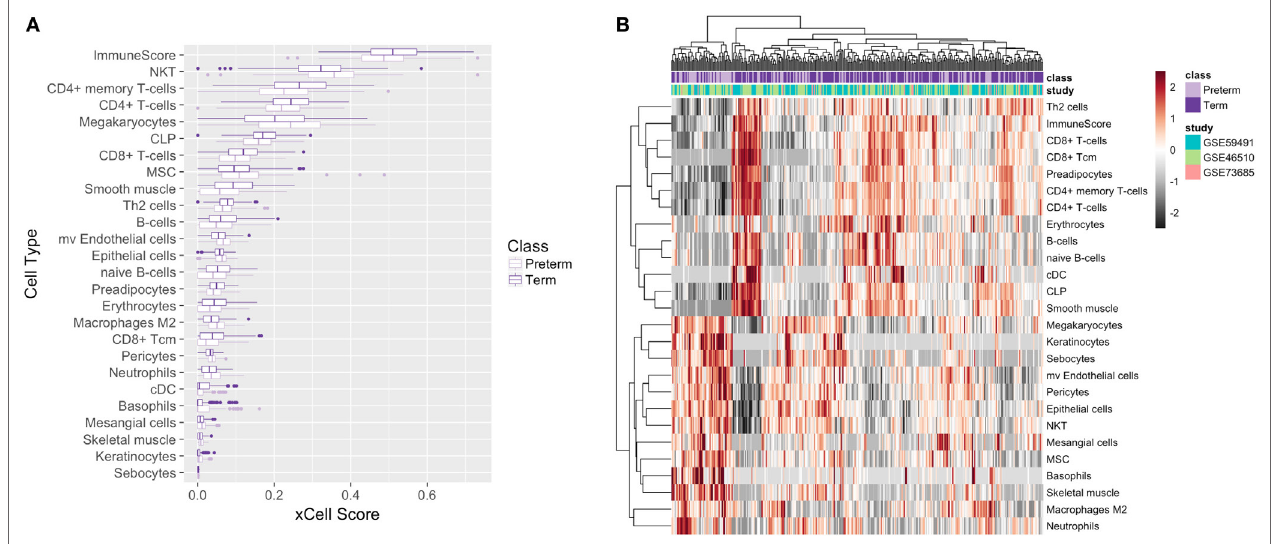
FiGURe 5 | Cell deconvolution of 339 meta-analysis samples. Boxplot (a) and heatmap (B) of average xCell scores for enriched cell types.